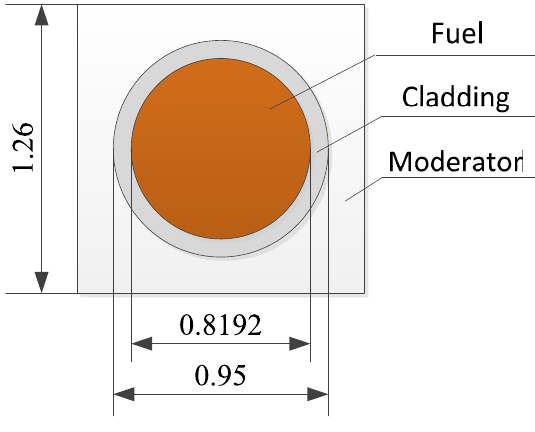
Figure 2. Common fuel cell